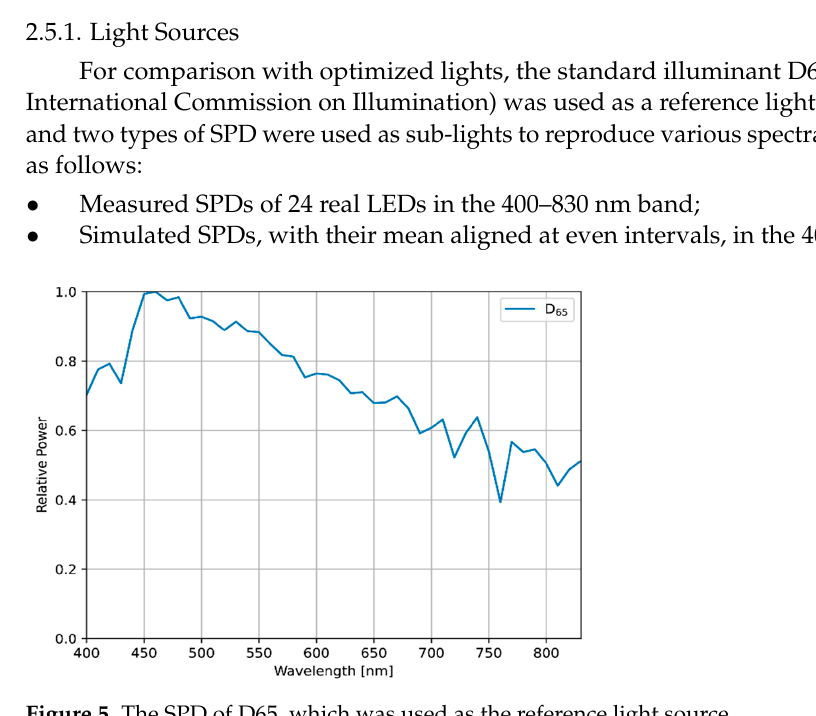
( b ) Figure 7. ( a ) The simulated sub-light source: each spectral distribution was computed by assuming a Gaussian distribution with a full-width at half maximum (FWHM) wavelength, 𝜆 (cid:2890)(cid:2907)(cid:2892)(cid:2897) = 40 nm , and its means are 412, 437, 462, 487, 512, 537, 562, 587, 612, 637, 662, 687, 712, 737, 762, 787, 812, 837, 862, 887, 912, 937, 962, and 987 nm. ( b ) The approximation of the D65 standard illumination spectral distribution with band-adjusted sub-light sources is represented in ( a ). Table 3. The specification of sub-lights. Sub-Light Peek Wavelength [nm] Measured